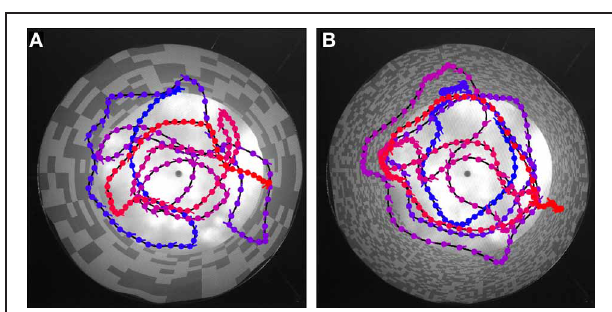
FIGURE 7 | Trajectory examples for behavior in the different textures. The cylindrical arena is shown in top-view. (A) Coarse texture, (B) fine texture. Color in the trajectories indicates time: Blue indicates the start, red the final position. Blobs indicate fly position, line markers at each blob position indicate body orientation (pointing toward